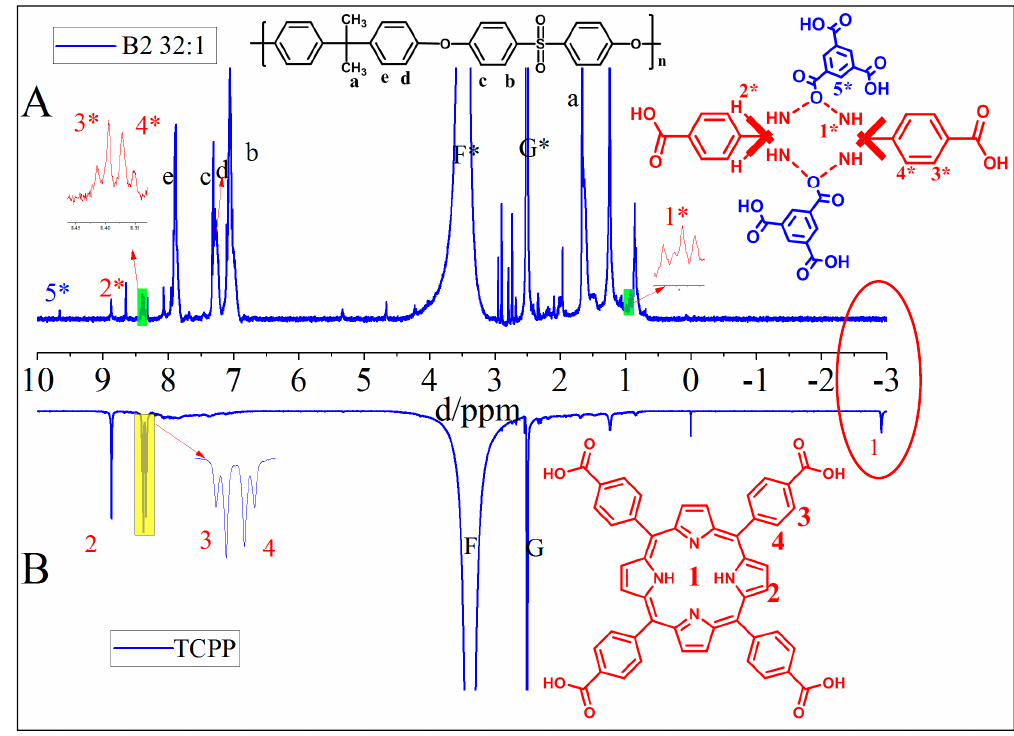
Figure 4. 1 H NMR spectra of ( A ) B2 32:1 membrane and ( B ) as-prepared TCPP.